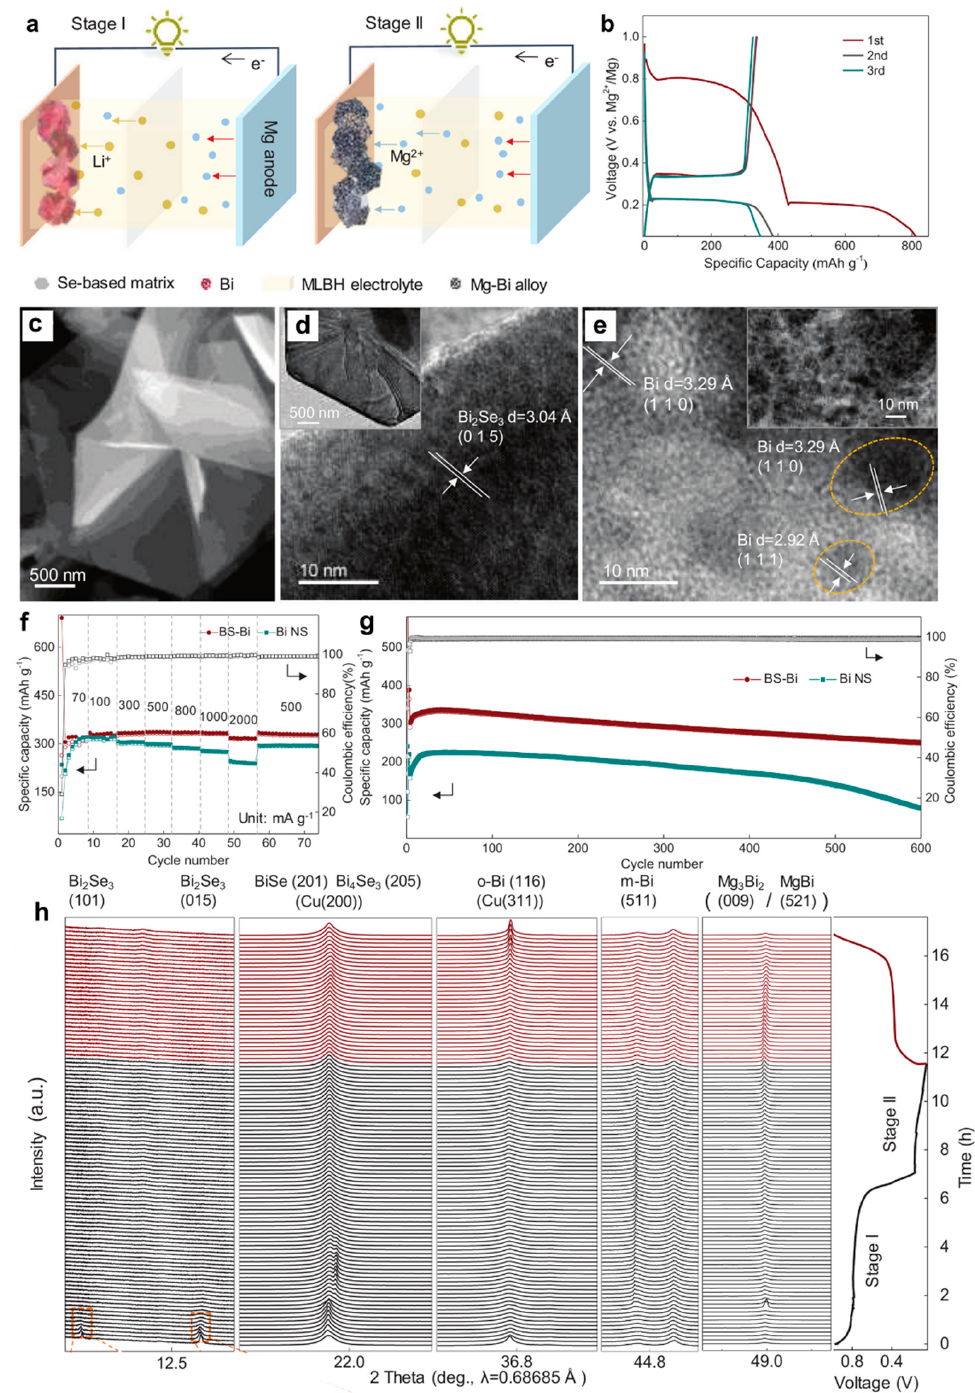
Figure 10. ( a ) Schematic illustration of the two-stage working mechanism of the BS-Bi electrodes. ( b ) Discharge/charge curves of BS-Bi electrode at the current density of 0.1 A g − 1 . ( c ) SEM and ( d ) TEM images of the Bi 2 Se 3 nanosheets. ( e ) HRTEM image of nanostructured m-Bi obtained from the initial discharge of Bi 2 Se 3 at a cut-off voltage of 0.75 V. ( f ) Rate performance and ( g ) cycling stability of the BS-Bi and Bi NS electrodes. ( h ) Operando synchrotron XRD patterns of the BS-Bi electrode and the corresponding discharge/charge curve. Reproduced with permission [44]. Copyright 2022, Wiley-VCH Verlag GmbH & Co. KGaA.